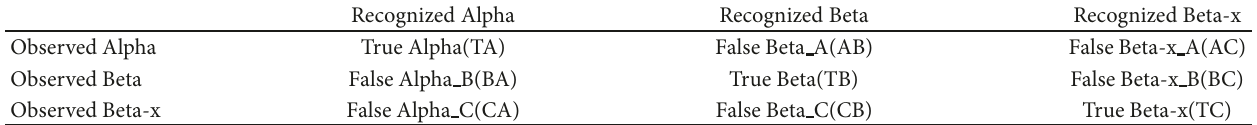
Table 4: Three-class confusion